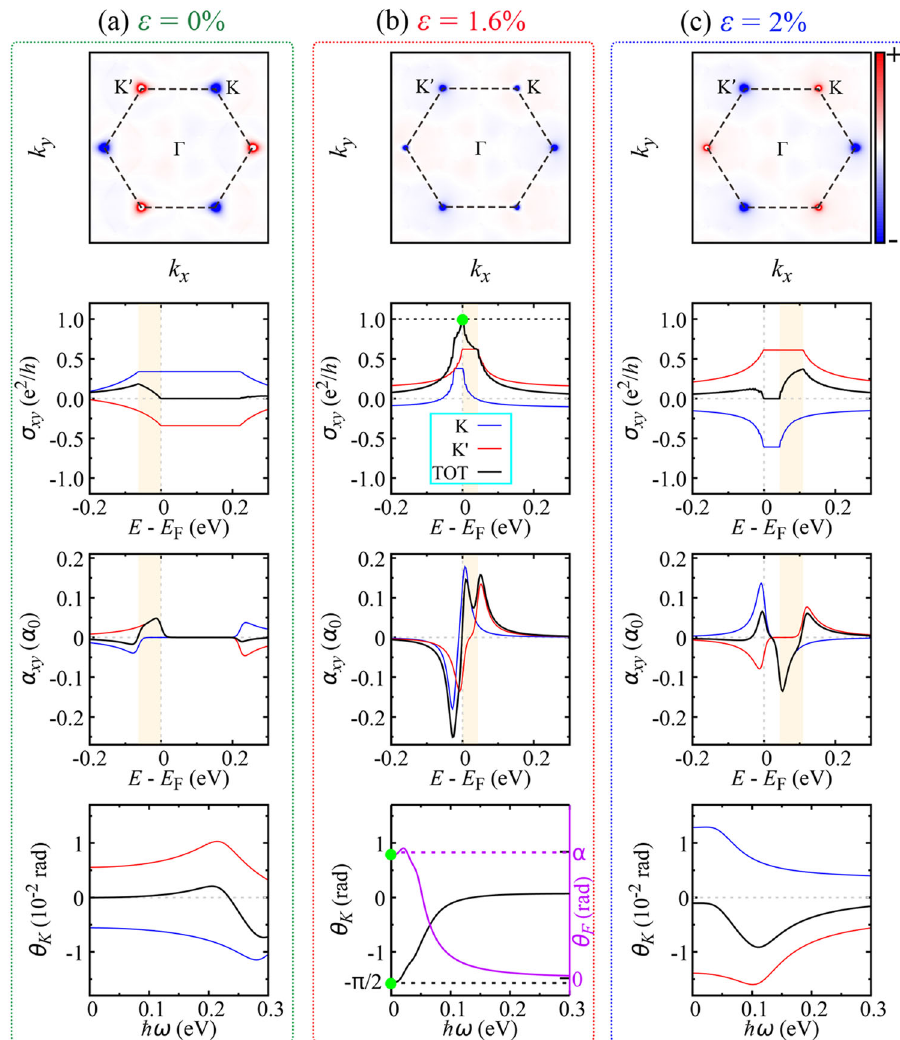
Fig. 3 Sign-reversible valley-dependent anomalous transport properties in VSi 2 N 4 . The Berry curvature Ω ( k ) ( fi rst row), VAHE (second row), VANE (third row), and VMOKE (fourth row) under three different strains of 0% ( a ), 1.6% ( b ), and 2% ( c ), respectively. The results of VMOFE (not shown here) are rather similar to that of VMOKE. The unit of VANE is set to be α 0 = k B e/ h (e is the elementary charge, k B and h are Boltzmann and Planck constants, respectively). Yellow shaded areas indicate the regions of large valley splitting. The Berry curvature is plotted at